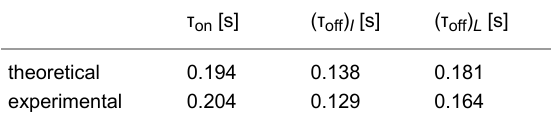
Table 2: Relaxation times of the 5CB + SWCNTs